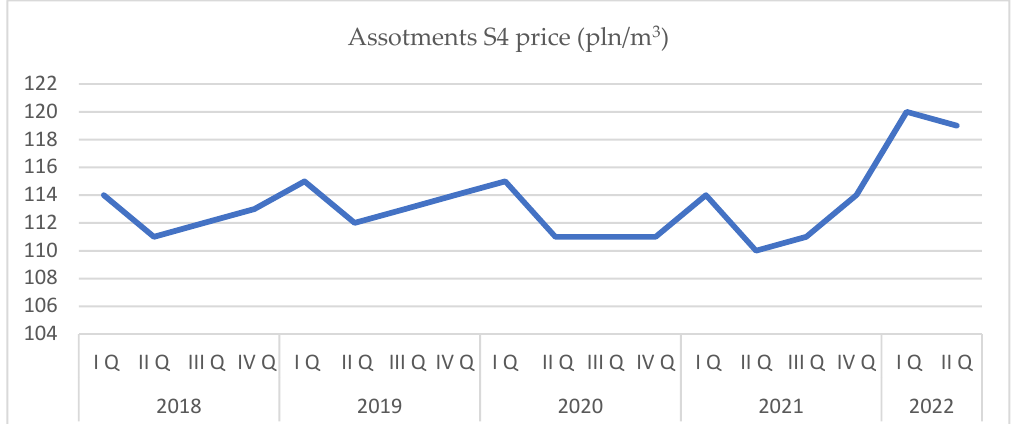
Figure 8. Prices for the S4 assortment at quarterly intervals in years 2018–2022. Source: Own elaboration based on data obtained from the State Forests IT System (SILP).